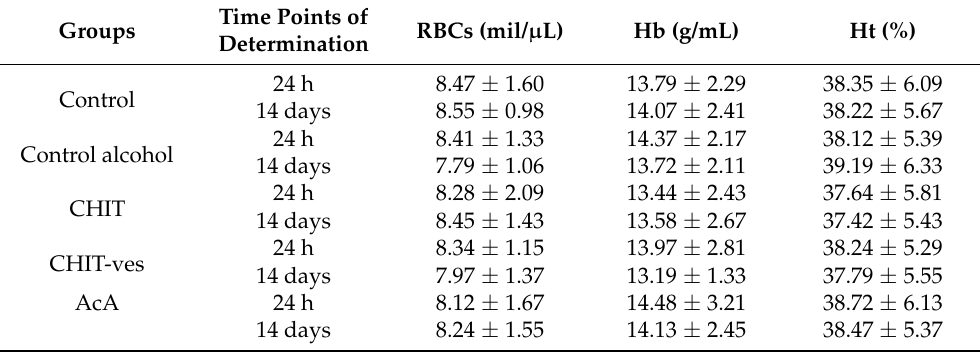
Table 2. The effects of chitosan, chitosan vesiclesand ascorbic acidon the number of RBCs and blood values of Hb and Ht in mice (mean ± S.D. of the average values—groups of 6 animals). Time Points of Groups